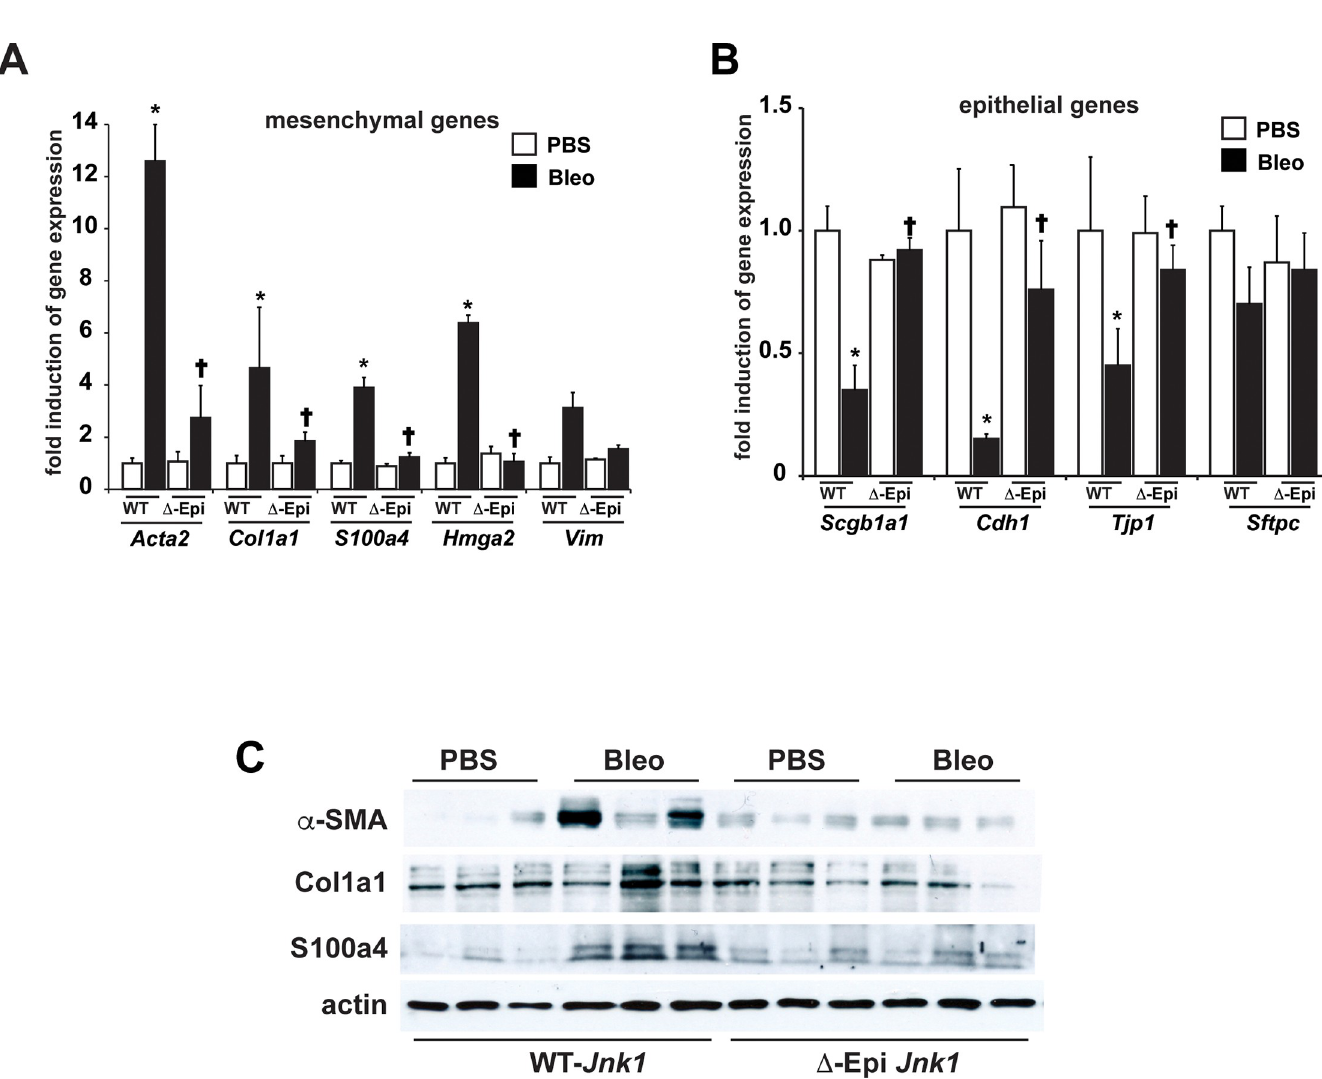
Fig 5. Evaluation of epithelial and mesenchymal gene expression profiles in lungs from Δ Epi Jnk1 mice, or control groups subjected to bleomycin-induced lung fibrosis. Analysis of mesenchymal ( A ) or epithelial ( B ) mRNA expression in homogenized lung tissue from mice exposed to bleomycin for 3 weeks. Results were normalized to the housekeeping gene cyclophilin, and are expressed as fold expression changes (+/- SEM) compared to the WT vehicle control groups. (WT- Jnk1 : PBS n = 6, Bleo n = 12, Δ Epi Jnk1 : PBS n = 5, Bleo n = 8 respectively mice/group from 2 independent experiments). � p < 0.05 compared to the PBS control group. † p < 0.05 compared to the respective WT group. (ANOVA). C : Evaluation of mesenchymal proteins ( α -SMA ( Acta2 ), Col1a1, FSP1 ( S100a4 )) in lungs from Δ EpiJNK1 mice, or control groups subjected to bleomycin-induced lung fibrosis, and the impact of ablation of epithelial JNK1. Homogenized lung tissues were subjected to Western blot analysis for the indicated proteins. β -actin: Loading control. Shown are results from individual